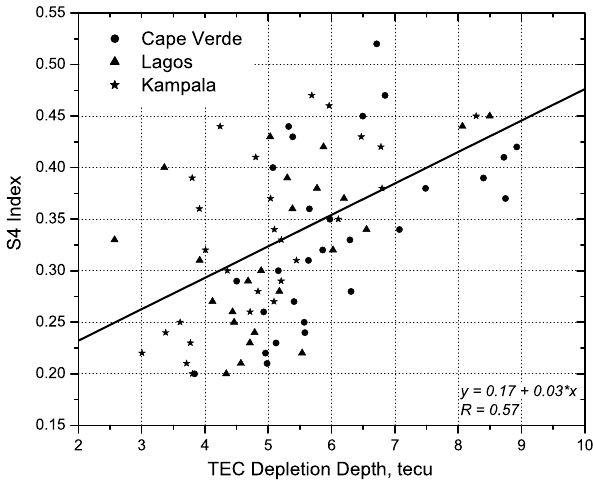
Fig. 6. Relation between the GPS scintillation intensity and TEC depletion depth (in TECU). Data from three stations Cape Verde, Lagos, and Kampala representing three regions are shown. A best linear fit line is shown with fit coefficients given in the lower right